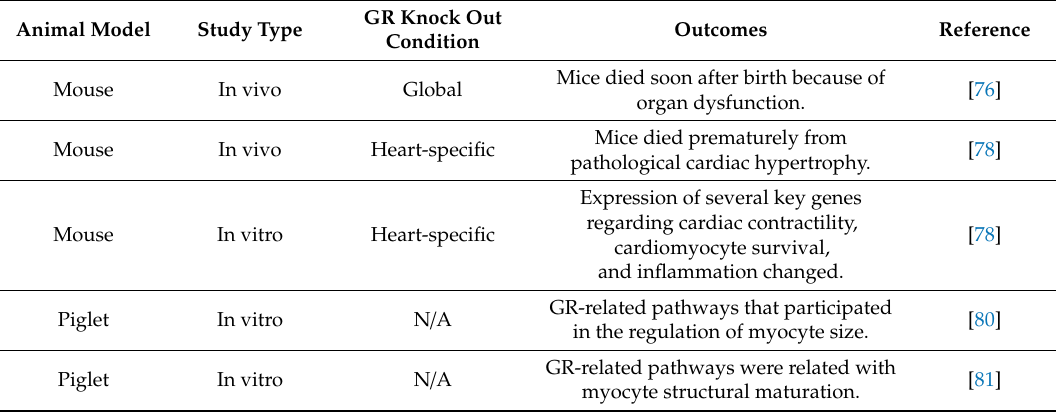
Table 2. The summary of GR in cardiac